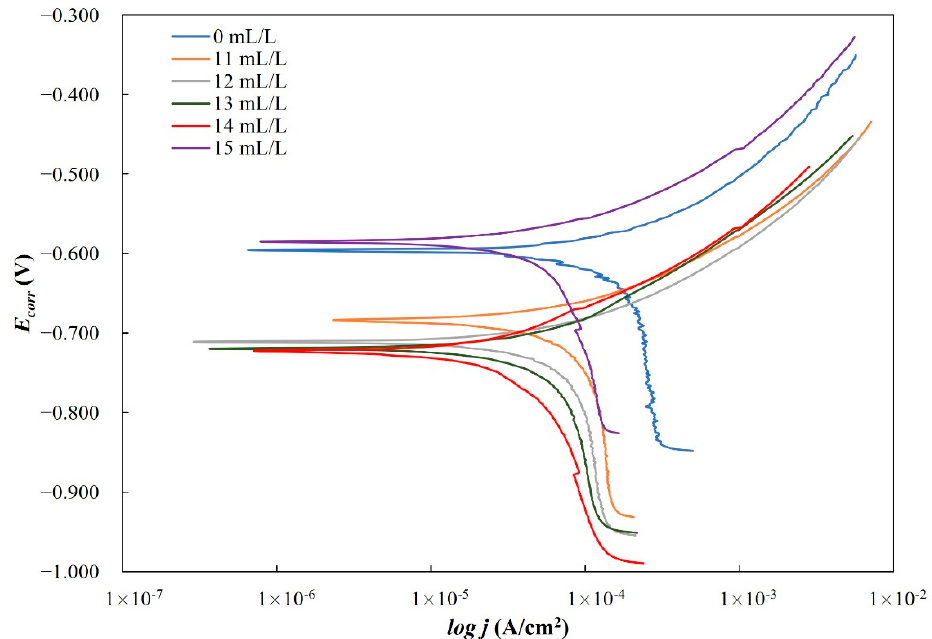
Figure 3. Polarization curves scanned on the carbon-steel sample in the simulated brine saturated with CO 2 with and without inhibitor in flow conditions (Adapted from [24]). Table 4. Electrochemical parameters determined from polarization curves scanned on the carbon ‐ steel sample in the simulated brine saturated with CO 2 with and without inhibitor in flow conditions (Data from [24]).